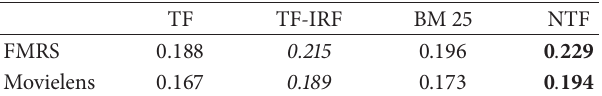
Table 3: The performance with different paradigms in Collaborative on two data sets.